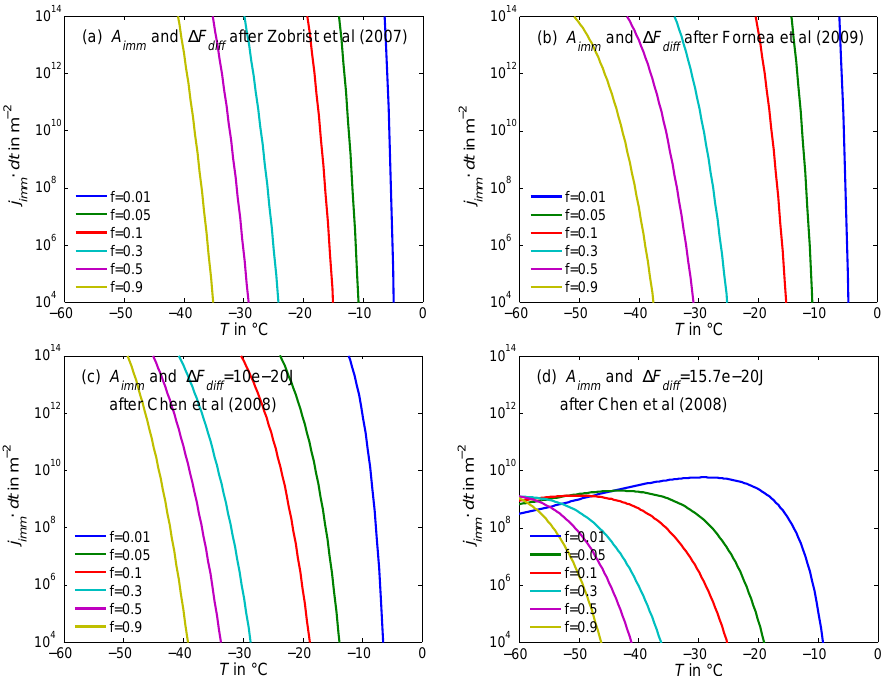
Fig. A3. Equivalent INAS densities calculated obtained from various formulations of classical nucleation theory by multiplying immersion freezing rate coefficients with an exemplary time step of 10s, shown for different form factors f